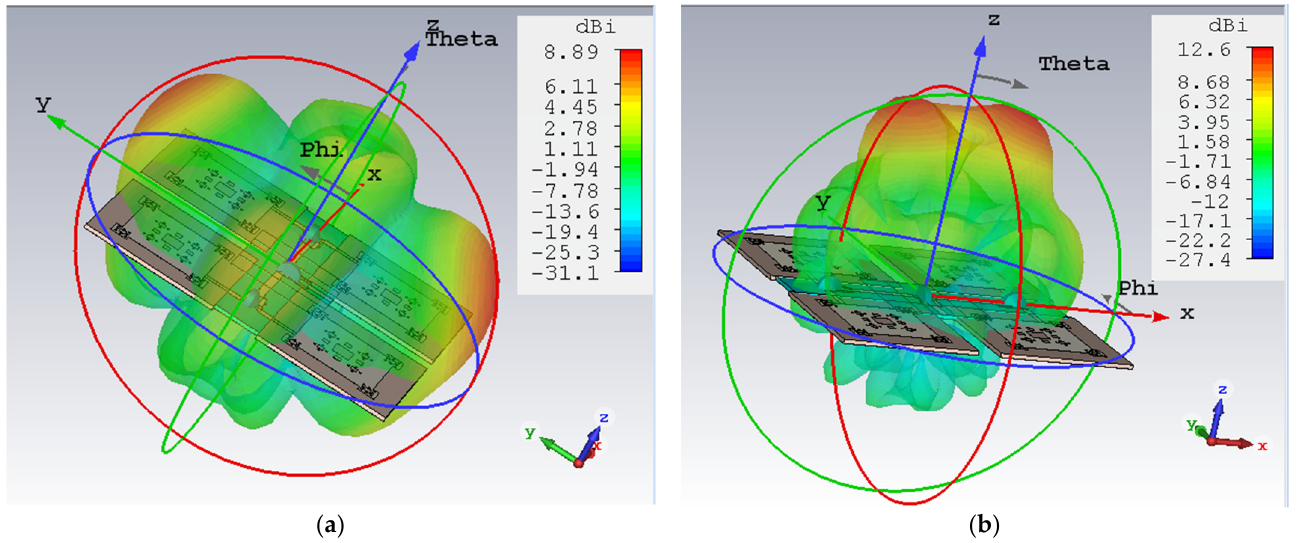
Figure 10. Shows 3D radiation patterns of four-element MSFAA at ( a ) 4.17 GHz (gain 8.89 dB) and ( b ) 5.97 GHz (gain 12.6 dB), respectively.